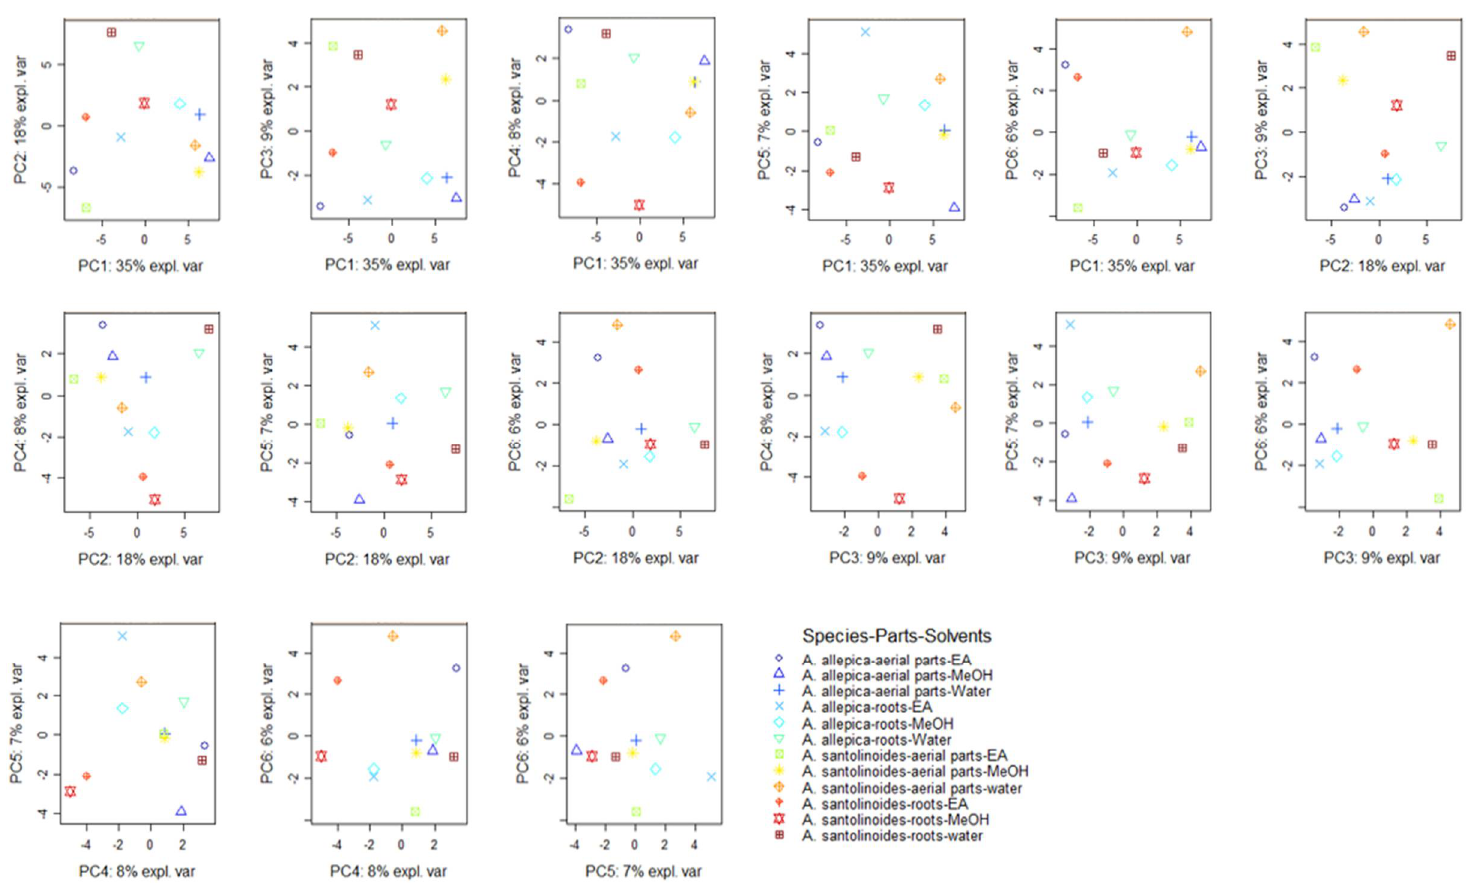
Figure 1. score plots of principal component analysis on the relative quantitative metabolites data of Achillea species.